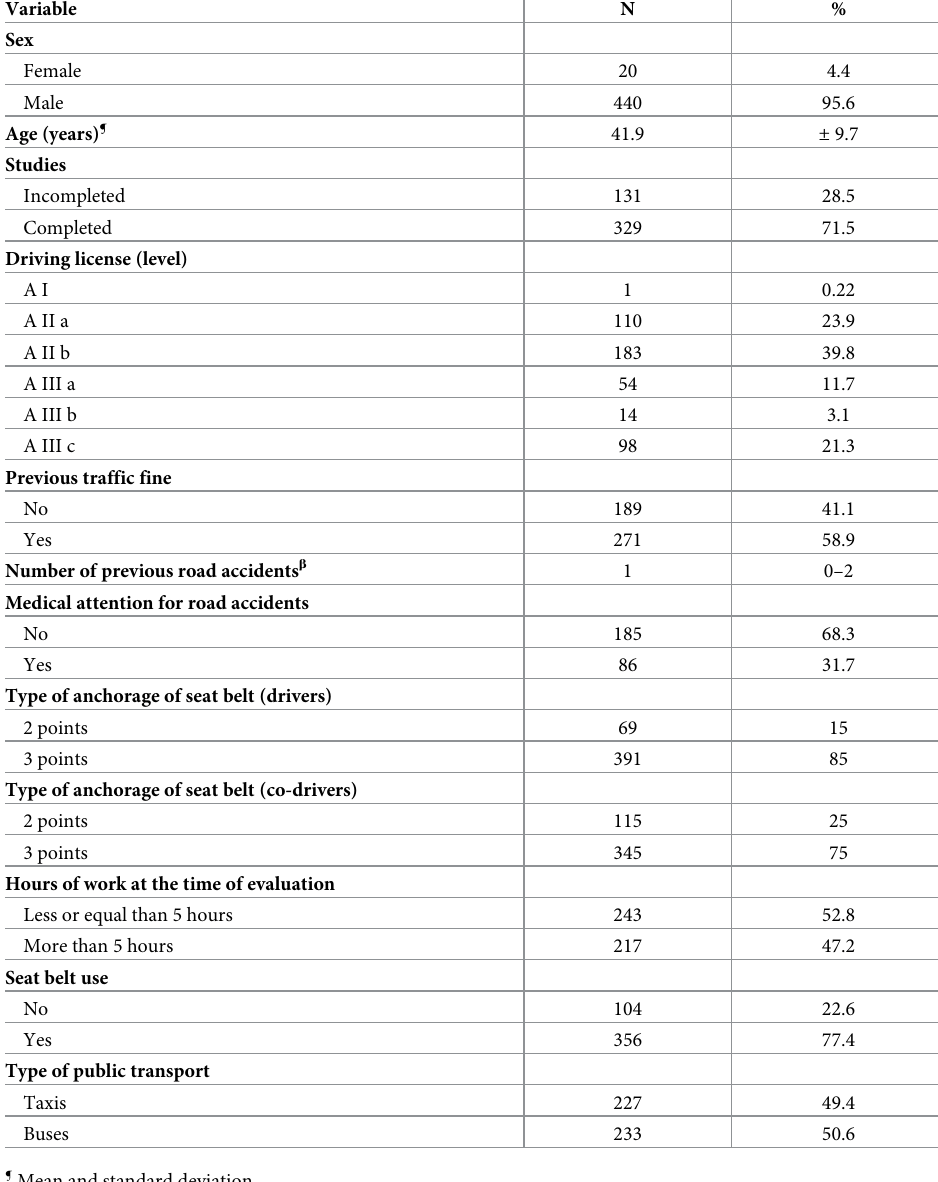
Table 1. General characteristics of the drivers